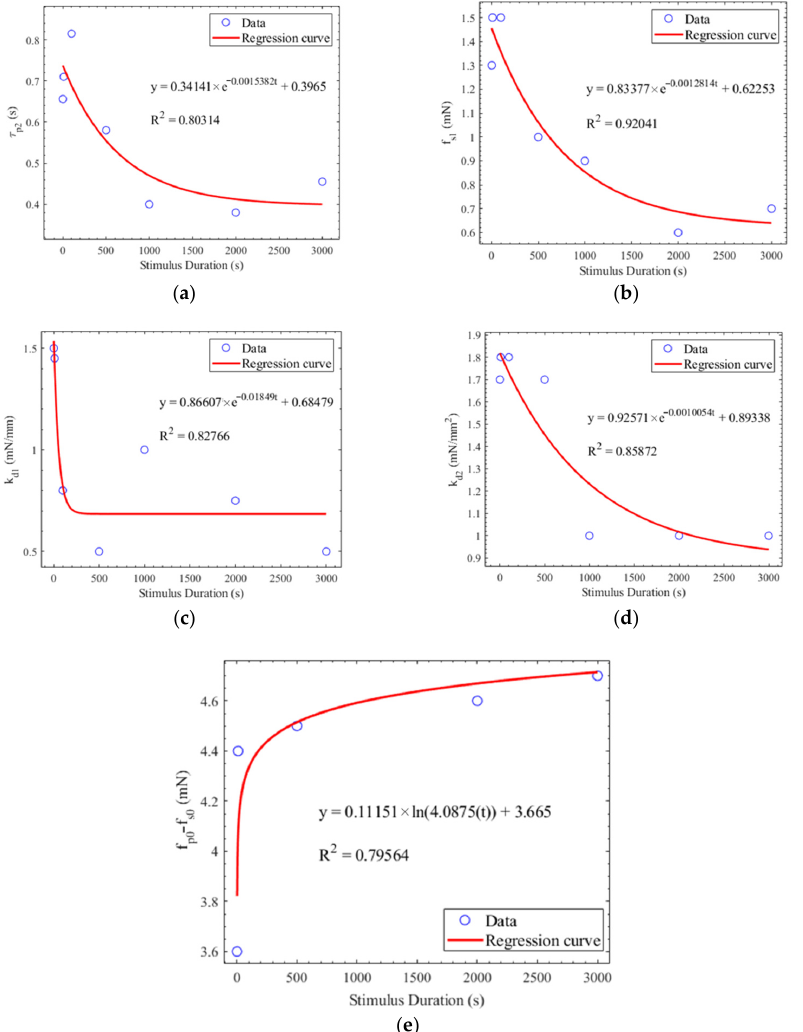
Figure 8. (a ) Regression between 𝜏 (cid:3043)(cid:2870) and the stimulus duration. (b) Regression between 𝑓 (cid:3046)(cid:2869) and Figure 8. ( a ) Regression between τ p 2 and the stimulus duration. ( b ) Regression between f s 1 and the the stimulus duration. (c) Regression between 𝑘 (cid:3031)(cid:2869) and the stimulus duration. (d) Regression be- stimulus duration. ( c ) Regression between k d 1 and the stimulus duration. ( d ) Regression between k d 2 tween 𝑘 (cid:3031)(cid:2870) and the stimulus duration. (e) Regression between 𝑓 (cid:3043)(cid:2868) − 𝑓 (cid:3046)(cid:2868) and the stimulus duration. and the stimulus duration. ( e ) Regression between f p 0 - f s 0 and the stimulus duration.